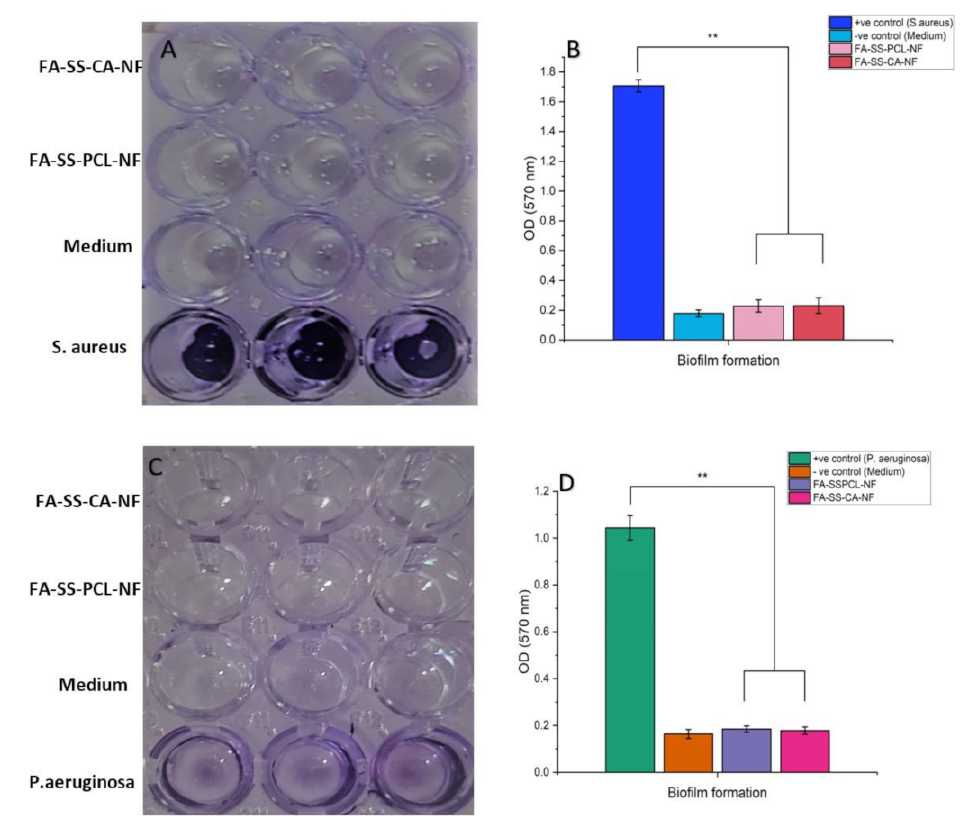
Figure 9. Quantitative estimation of biofilm formed in the presence of nanofibrous mats loaded with FA, medium control, or test bacterium. ( A , C ) Microplate wells before absorbance reading. ( B , D ) Average absorbance of triplicate. ** represent the significant differences between positive control and the formulations.